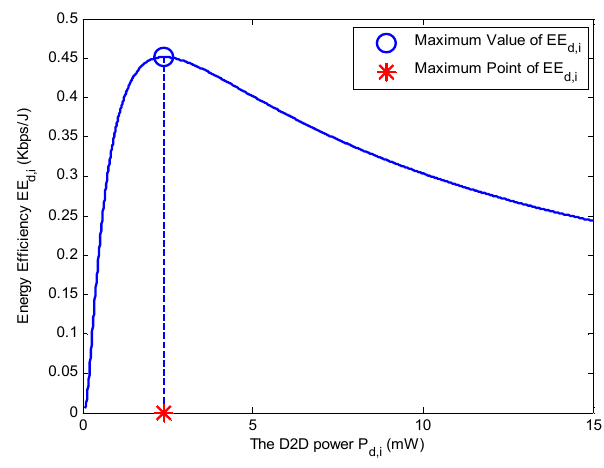
Figure 9. EE against D2D power.